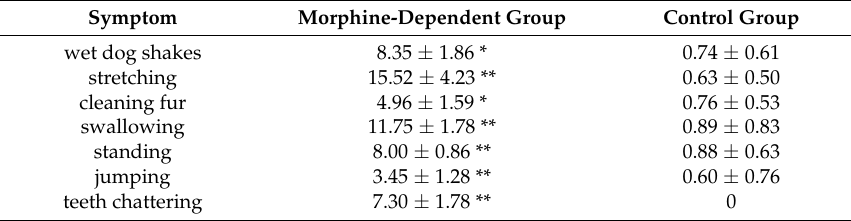
Table 1. Results of the count of withdrawal